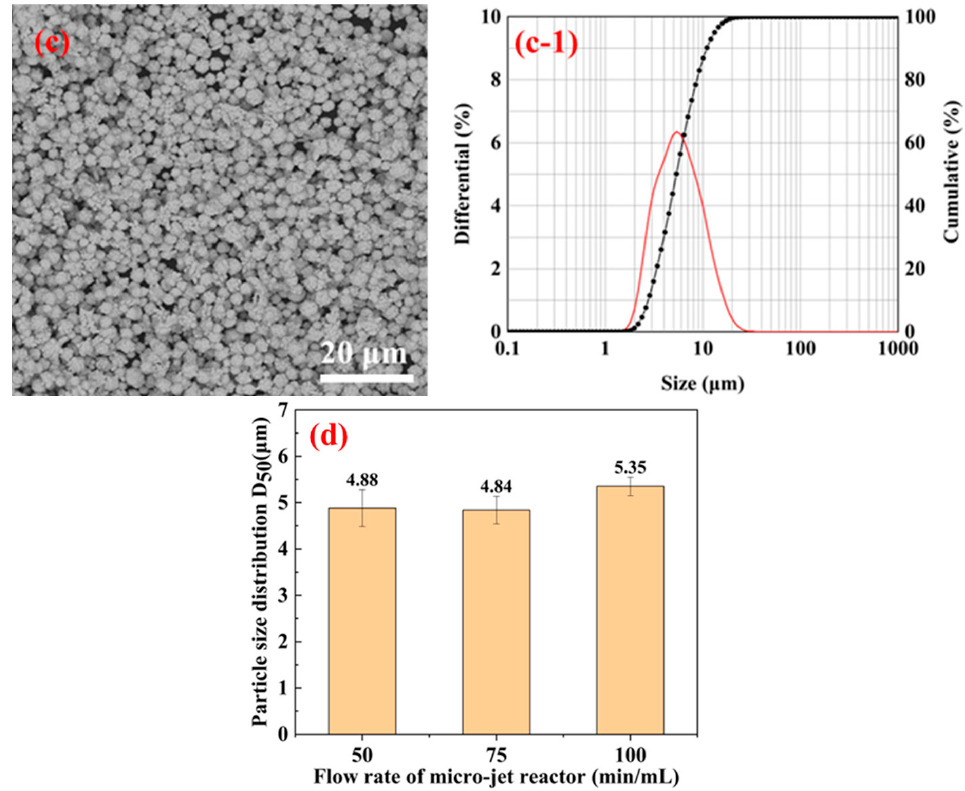
Figure 8. SEM images, particle size distributions, and D 50 distributions of the silver powder prepared by adding 1% gelatin under different jet flow rates. ( a ) 50 mL/min; ( b ) 75 mL/min; ( c ) 100 mL/min; and ( d ) D 50 distribution of silver powder.